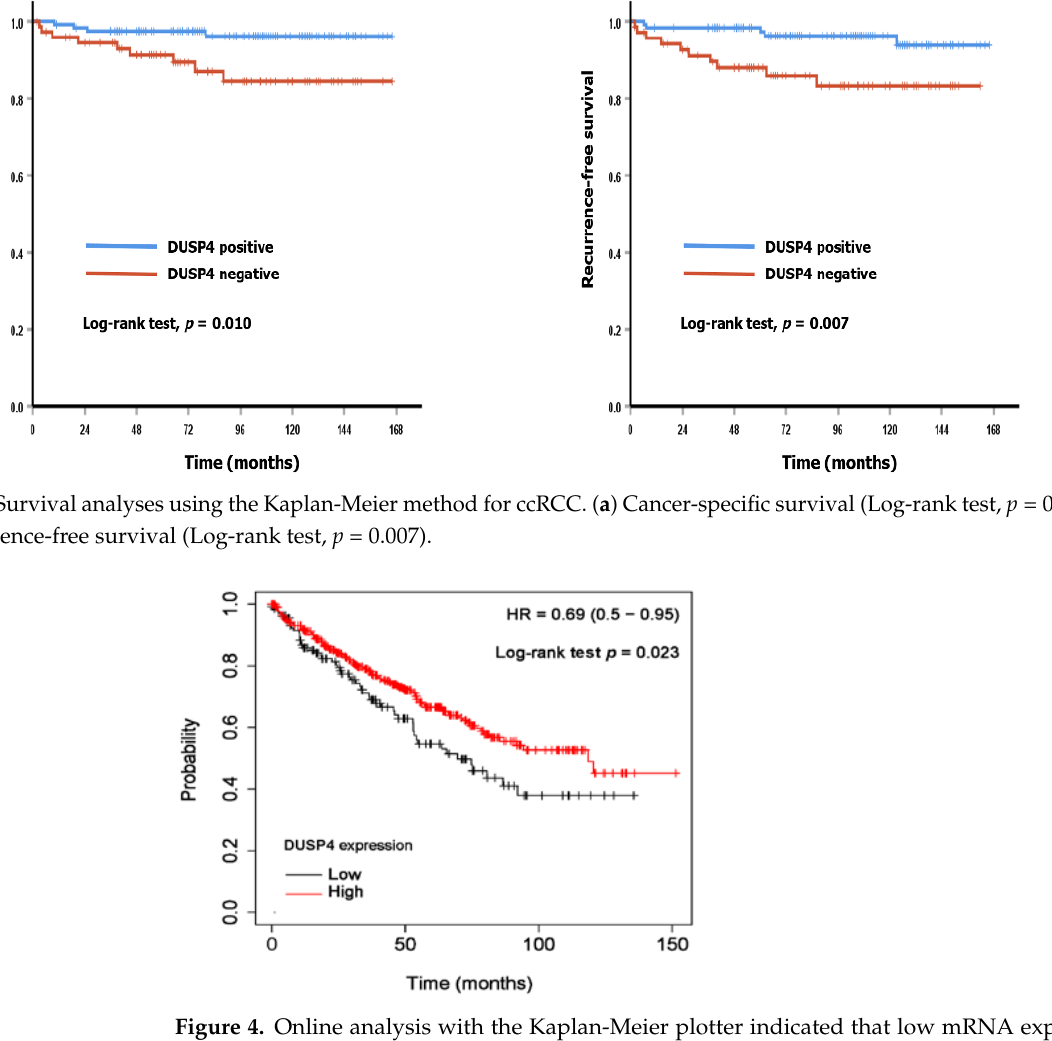
Figure 4. Online analysis with the Kaplan-Meier plotter indicated that low mRNA expression of DUSP4 suggested a poor prognosis in ccRCC patients ( n = 530; Log-rank test, p = 0.023).